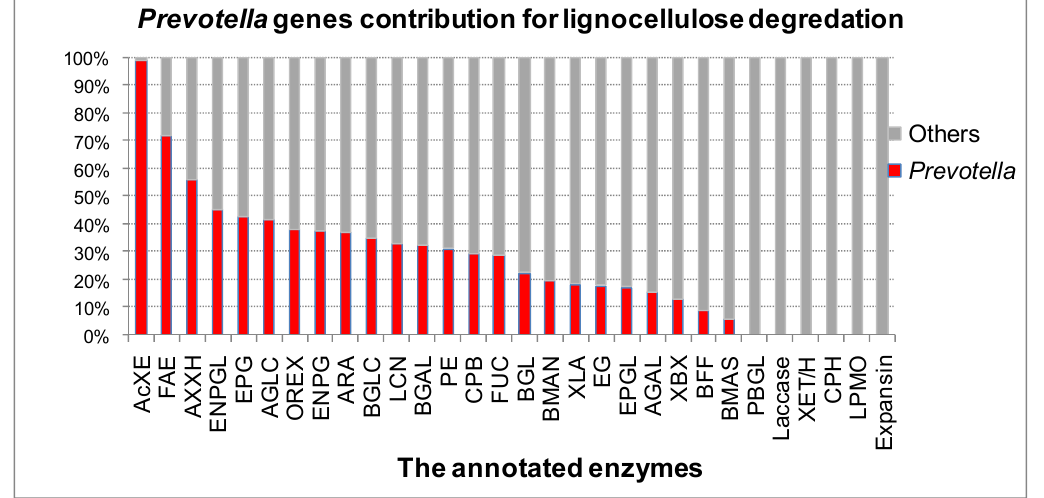
Figure 4. Bacterial contribution for lignocellulose digestion analyzed by metagenomic deep sequencing data of bacteria in Vietnamese goats’ rumen. The total genes included 17,495 genes that were functional annotated by KEGG, and 327 AcXE genes, 38 FAE genes, 258 EG genes were annotated by CAZy and HMMER. EG: Endoglucanase; CPB: Cellobiose phosphorylase; BGL: Beta glucosidase; PBGL: 6-Phospho-beta-glucosidase; CPH: Cellobiohydrolase; AcXE: Acetylxylan esterase; AXXH: Alpha-D-xyloside xylohydrolase; AGLC: Alpha-glucuronidase; BGLC: Beta-D-glucuronidase; BFF: Beta-fructofuranosidase; BMAS: Beta-mannosidase; XET/H: Endo-transglycosylase/hydrolase; XLA: Endo- β -1,4 xylanase; OREX: Oligosaccharide reducing-end xylanase; XBX: Xylan 1,4-beta-xylosidase; BGAL: Xyloglucan-active β -D-galactosidase; AGAL: Alpha-galactosidase; ARA: Alpha-L-arabinofuranosidase; FUC: Alpha-L-fucosidase; BMAN: Beta-mannanase: FAE: Feruloyl esterase; PE: Pectinesterase; EPG: Exopolygalacturonase; EPGL: Exopolygalacturonase lyase; ENPG: Endopolygalacturonase; ENPGL: Endopolygalacturonase lyase.